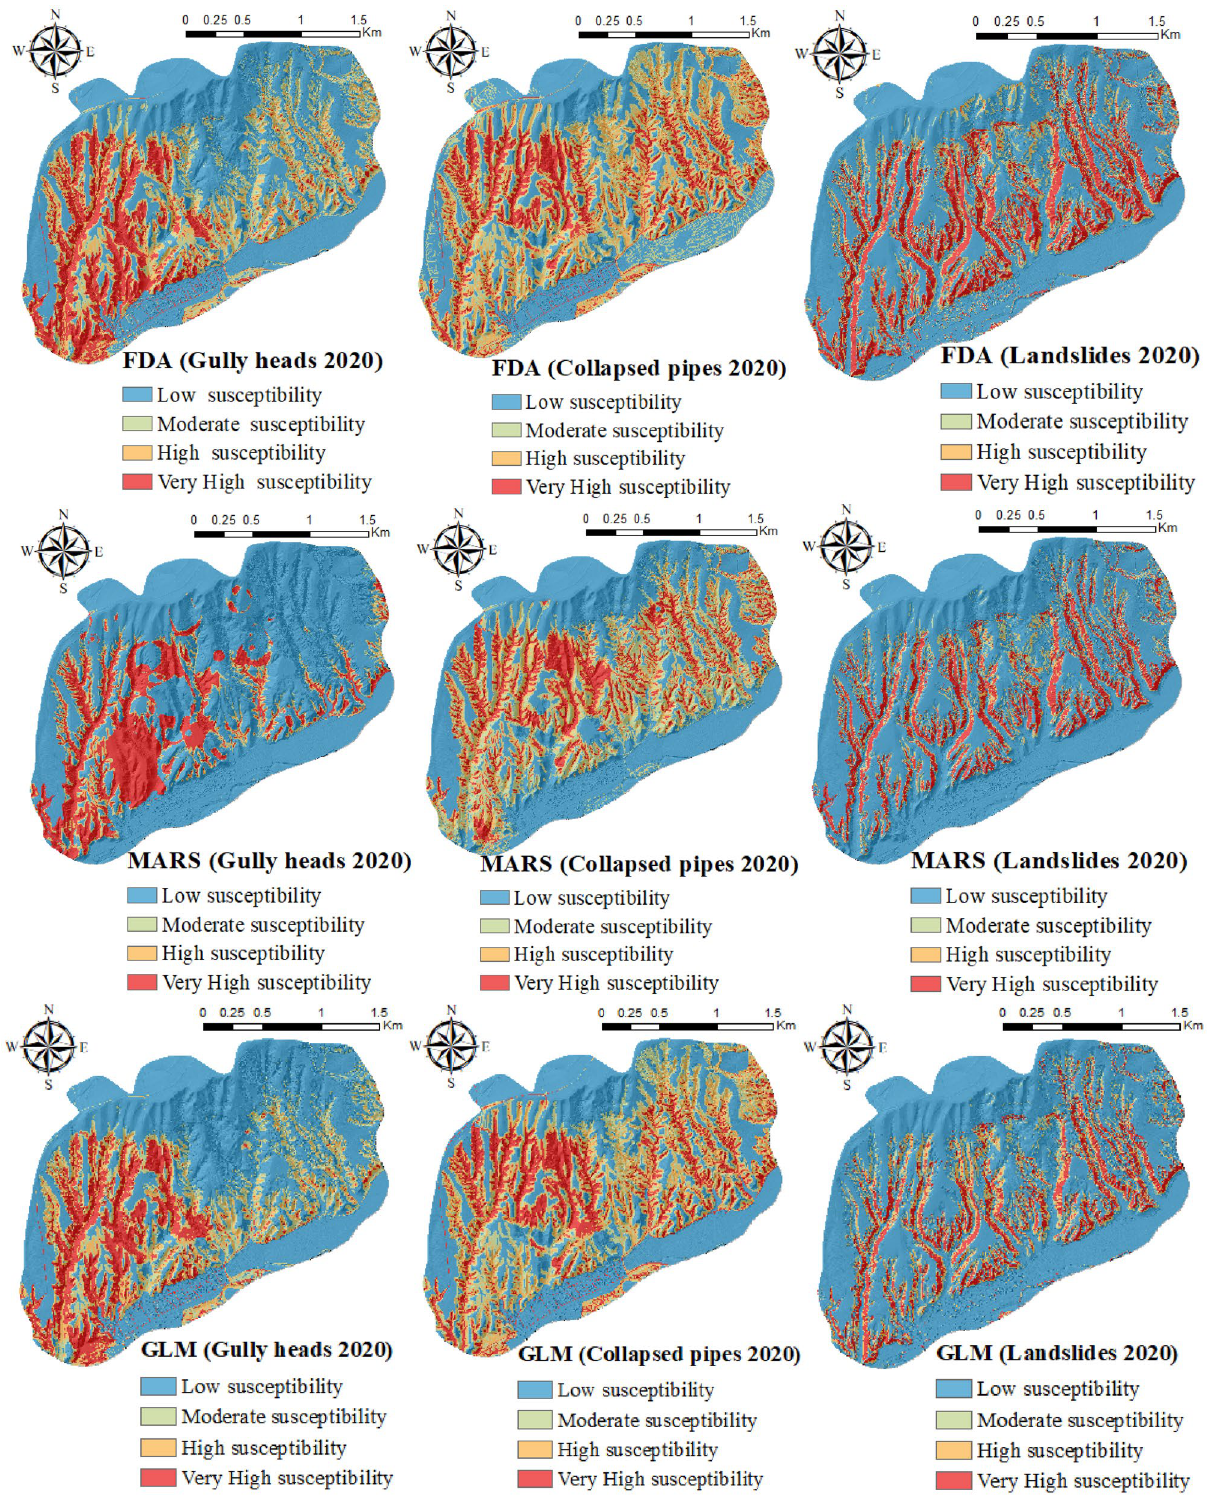
Figure 1. The susceptibility maps of three natural hazards produced using ArcGIS 10.3.1 software (https:// www. esri. com) in